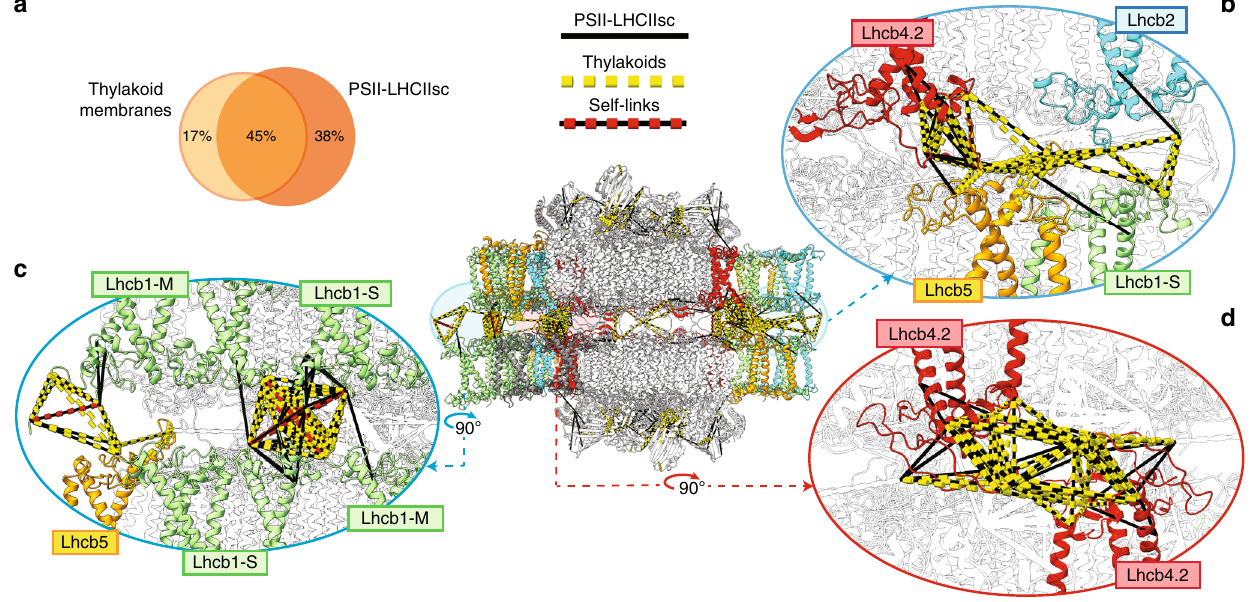
Fig. 5 Detection of paired PSII – LHCIIsc in stacked thylakoid membranes by in situ XL-MS with DSSO. a Side-view of the (C 2 S 2 M)×2 with mapped crosslinks found in at least two out of three thylakoid samples and two out of three PSII – LHCIIsc samples, together with the overlap of the two datasets. Enlarged views matching Figs. 3d, e and 4d are shown to highlight the positioning of Lhcb2 ( b ) and the occurrence of Lhcb1 and Lhcb4.2 mutual interactions ( c , d) in the thylakoid membranes. Crosslinks within the distance cut-off of 33 Å for DSSO either for isolated PSII – LHCIIsc (black lines) or thylakoid membranes (yellow dashed lines), and DSSO self-links (red dashed lines) are shown. Subunits not involved in crosslinks are left